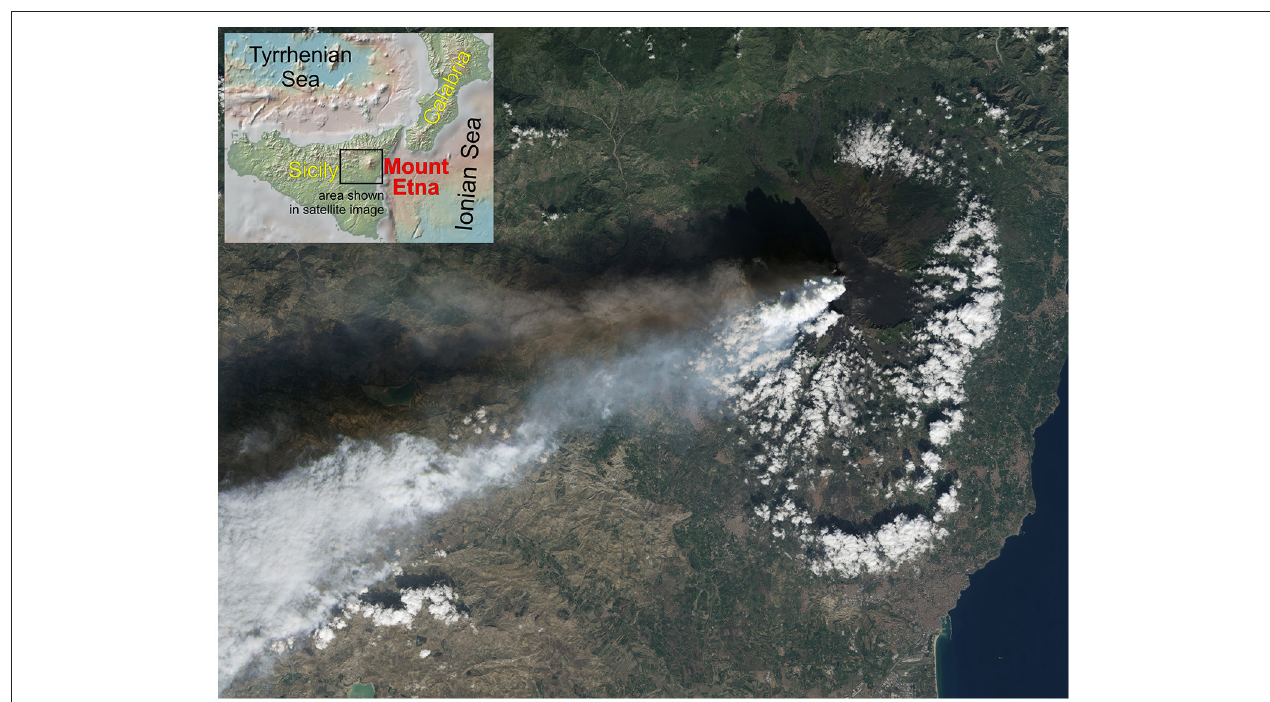
FIGURE 5 | Natural-color image collected by Landsat 8, showing the whitish eruption plume from the NSEC dispersed toward ∼ WSW of 26 October, 2013 at 11:38 (local time). The darker, shorter volcanic plume above the NSEC plume is emitted from the Northeast Crater and is traveling at a lower elevation than the NSEC plume. NASA Earth Observatory image by Jesse Allen and Robert Simmon, using Landsat data from the USGS Earth Explorer. Area of the image is shown in the index map at upper left. Photograph © 2013, at https://eoimages.gsfc.nasa.gov/images/imagerecords/82000/82287/etna_oli_2013299_lrg.jpg.